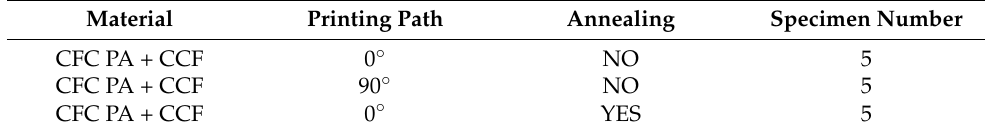
Table 2. Continuous FRP specimens test